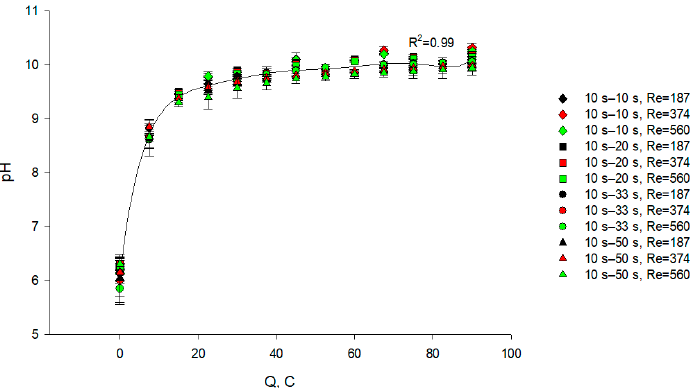
Figure 4. Evolution of pH in the KCl stream as a function of the amount of transferred charges (in C) during EDBM in PEF mode carried out at different flow rates (expressed in Reynolds numbers) and different pause durations; the regimes studied: 10 s–10 s, 10 s–20 s, 10 s–33 s and 10 s–50 s. Reynolds numbers of 187, 374 and 560 correspond to linear velocities of 7.8, 15.6 and 23.4 cm/s,